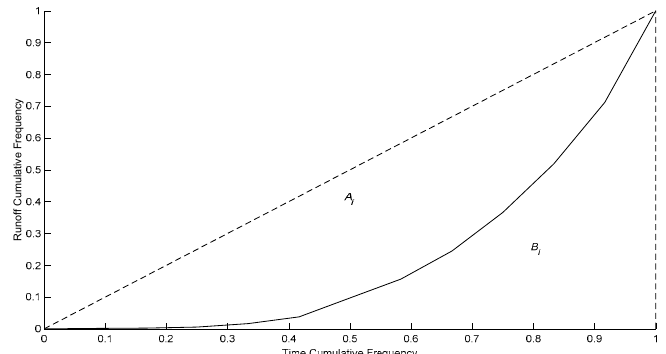
Figure A1. Lorenz curve of the annual distribution for monthly flow in 1956. Note: A i is a region bounded by Lorenz curve and dashed diagonal, B i is a region bounded by Lorenz curve and vertical diagonal.